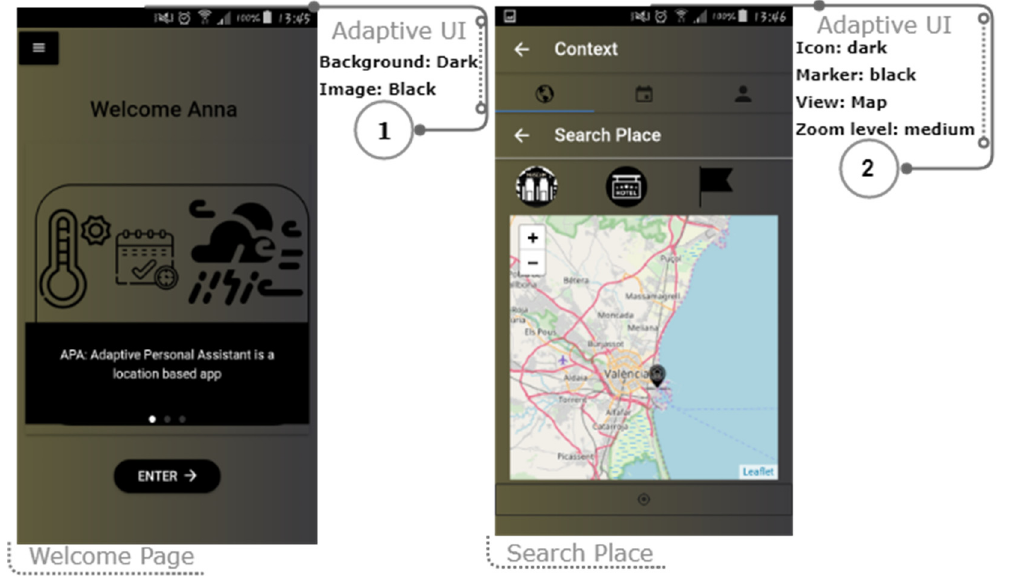
Figure 9. Scenario case adapted to color-blind users.